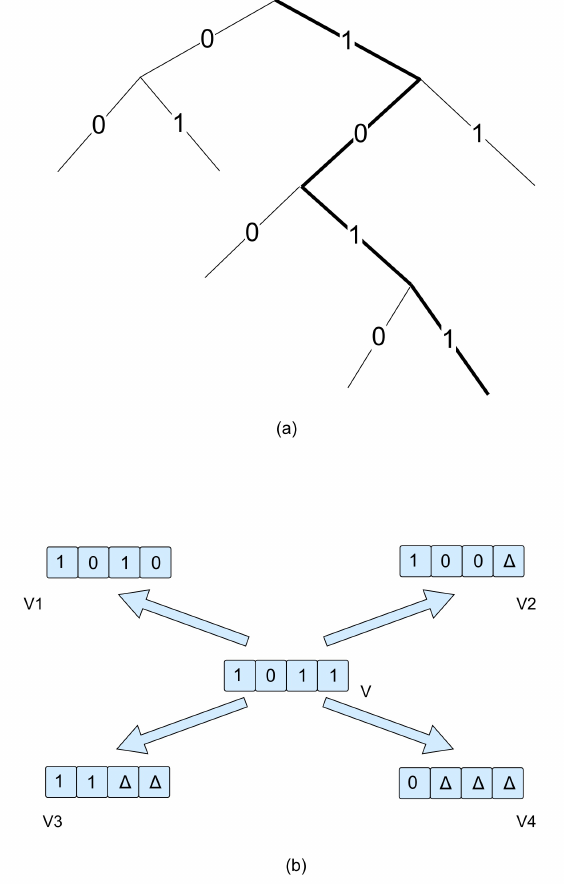
Figure 6. Neighborhood for one path. ( a ) denotes a path execution tree with a height of 4. ( b ) shows The construction of the neighborhood of element v